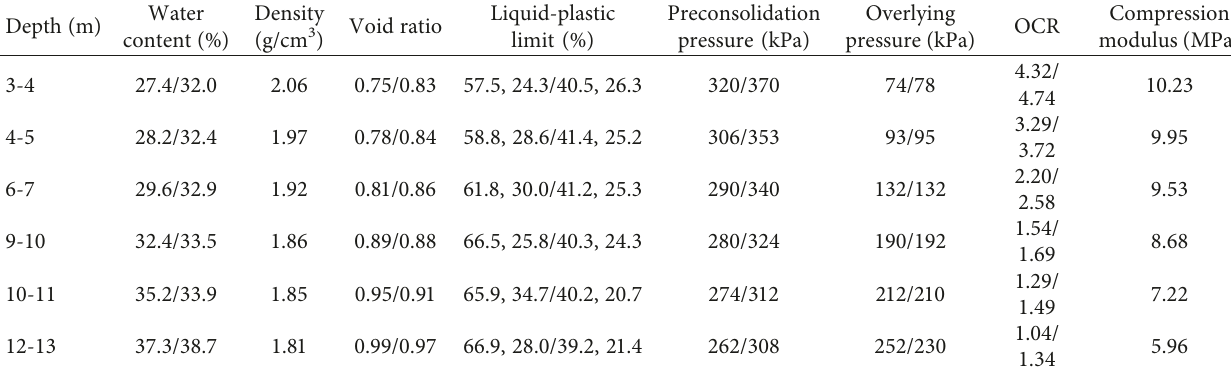
Table 3: Profile distribution of some indexes of red